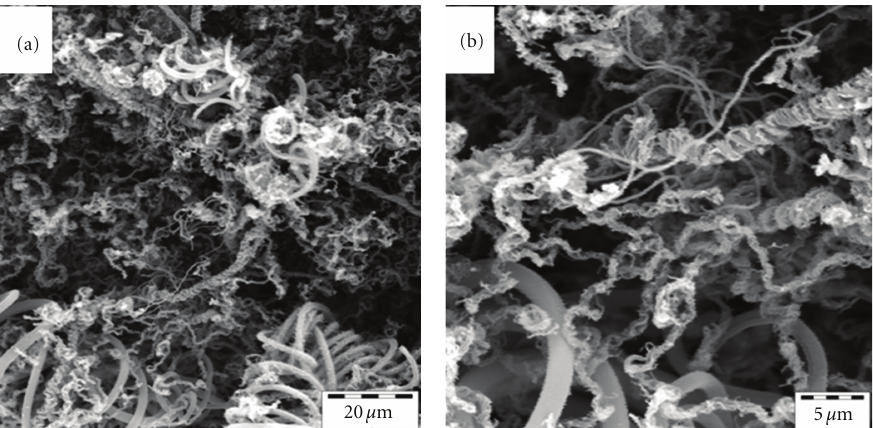
Figure 1: SEM images of LiFePO 4 /CNT composites synthesised with (a) Ni mist, 60 min deposition at 1000x and (b) Ni mist, 60 min deposition at 3000x magnification.